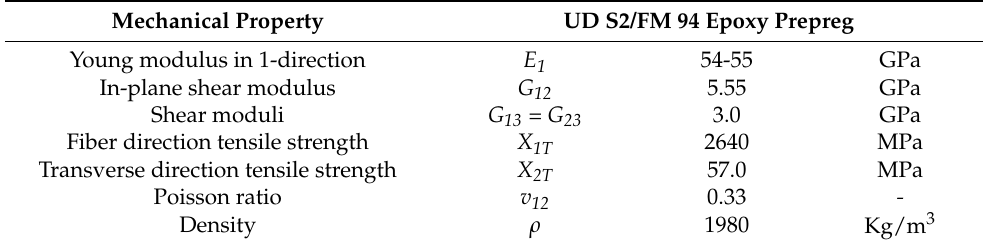
Table 2. Homogenized individual ply material properties of